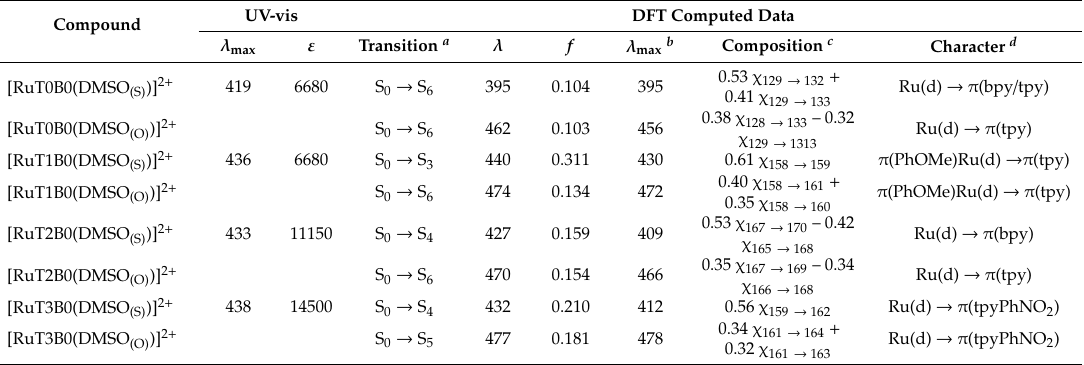
Table 6. Computed absorption maxima ( λ max in nm), oscillator strength ( f ), composition and main character of the low-energy transition of the Ru-DMSO (S) and Ru-DMSO (O) complexes, compared with the experimental data